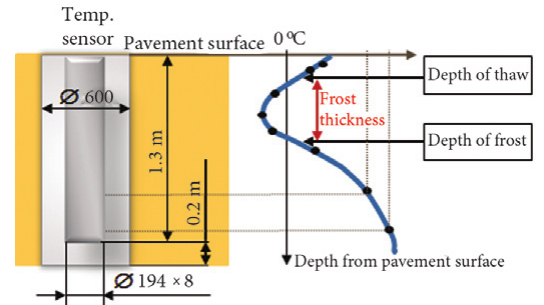
Fig. 3. Measurement of the frost